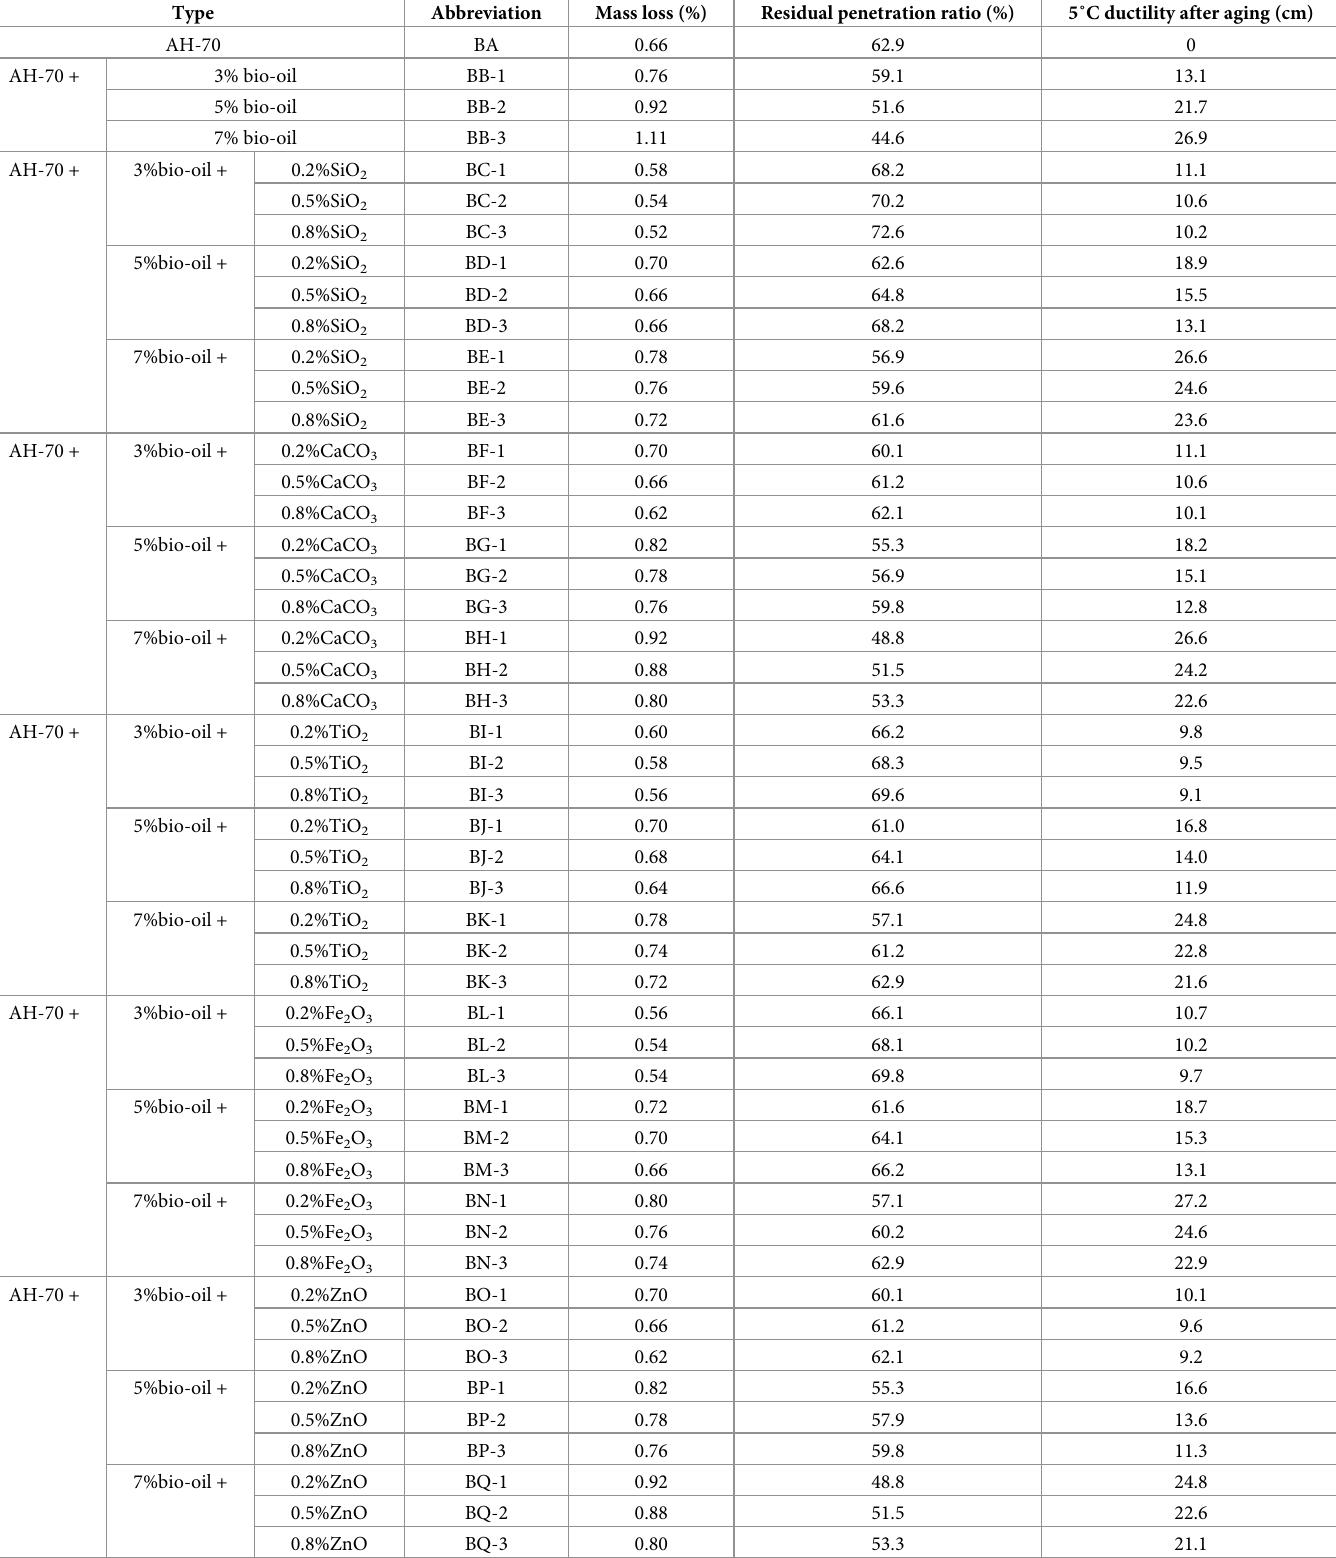
Table 7. Test results of different asphalt binders in